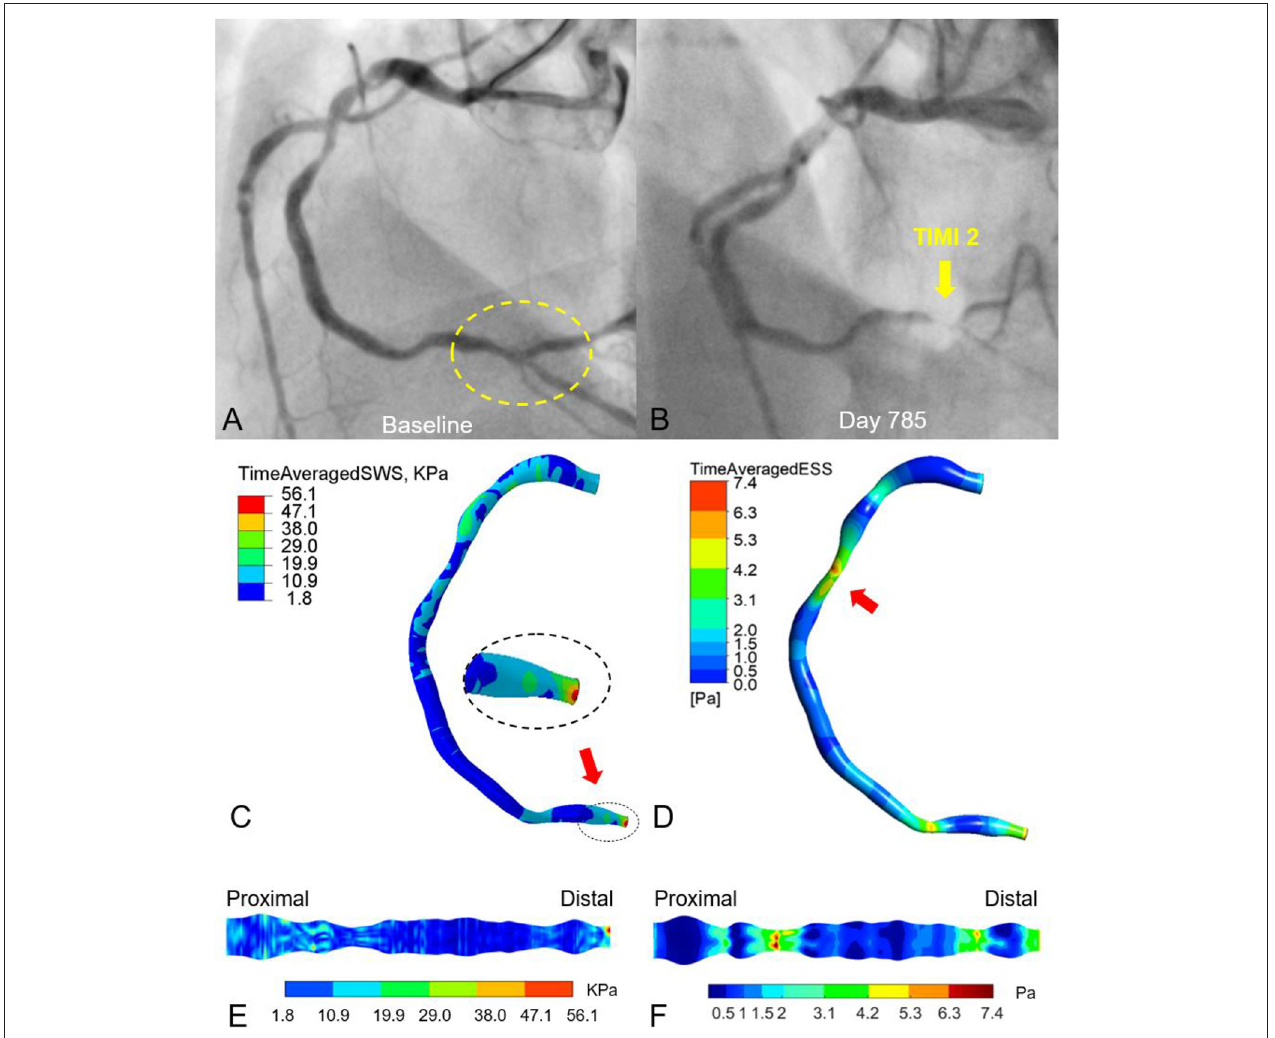
FIGURE 6 | Effects of vessel deformation-induced superficial wall stress and fluid-induced endothelial shear stress on plaque progression and clinical adverse events. The moderate lesions in proximal and distal RCA remained untreated according to physiological guidance with iFR (A) . On day 785, the patient was admitted to the hospital due to recurrent angina. Angiography demonstrated the progression of the distal RCA stenosis with impaired TIMI-2 coronary flow, suggesting plaque progression as well as potential atheroma rupture (B) . The time-averaged superficial wall stress was relatively high at the distal RCA with 56 kPa (C) and co-located with the site of late plaque rupture (B) . (D) Relatively high time-averaged endothelial shear stress (ESS) (6–7Pa) was located at the stenotic segments of proximal and distal RCA (lesions left untreated), while the mid-segment exhibits a very low ESS ( < 1Pa). (E,F) Expanded views of superficial wall stress and ESS